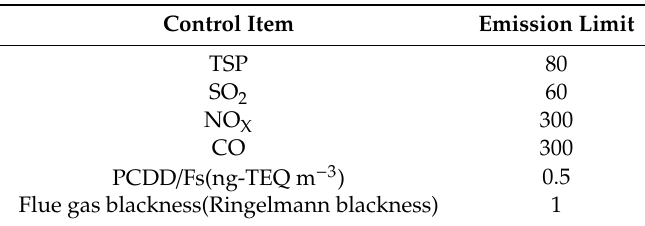
Table 2. Emission standard of air pollutants for crematory (GB 13801-2015) Unit: mg m − 3